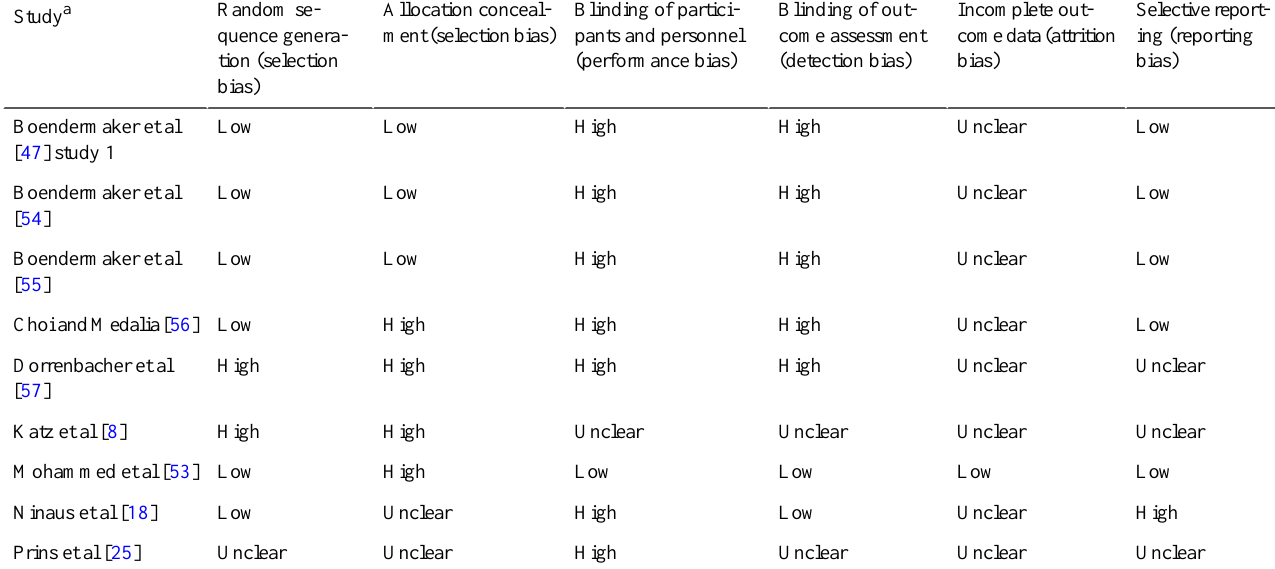
Table 4. Risk of bias assessment of the included